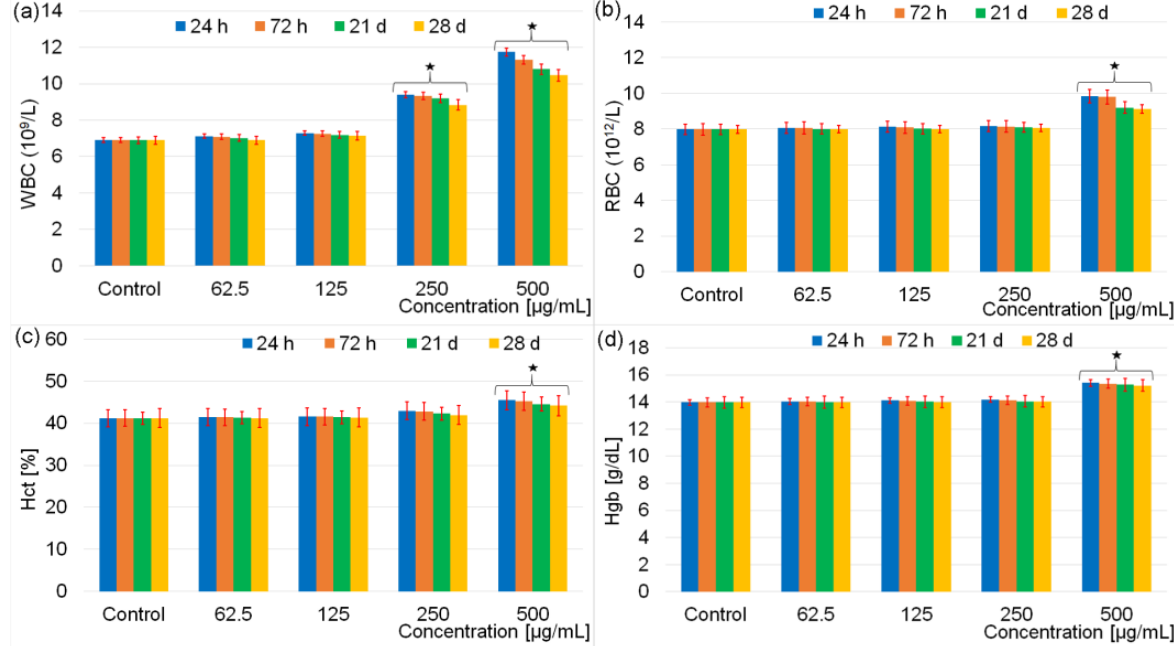
Figure 6. Hematological parameters for the rats exposed to different dose containing DIO-AMF at different time intervals. Red blood cells (RBC), white blood cells (WBC), hematocrit (HCT) and he- moglobin (Hgb). Represents important difference from the control group (* p < 0.05).